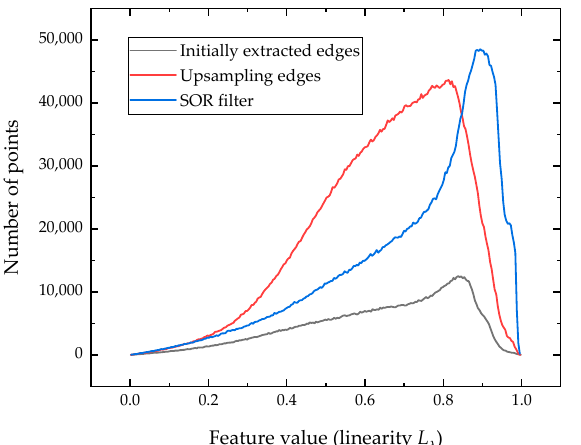
Figure 19. Frequency distribution of the point number with respect to the feature value (linearity L λ ) for the initially extracted edge points, upsampled edge points without using the SOR filter, and the upsampled edge points using the SOR filter. Table 6. Quantitative evaluation of the effects of the SOR filter.